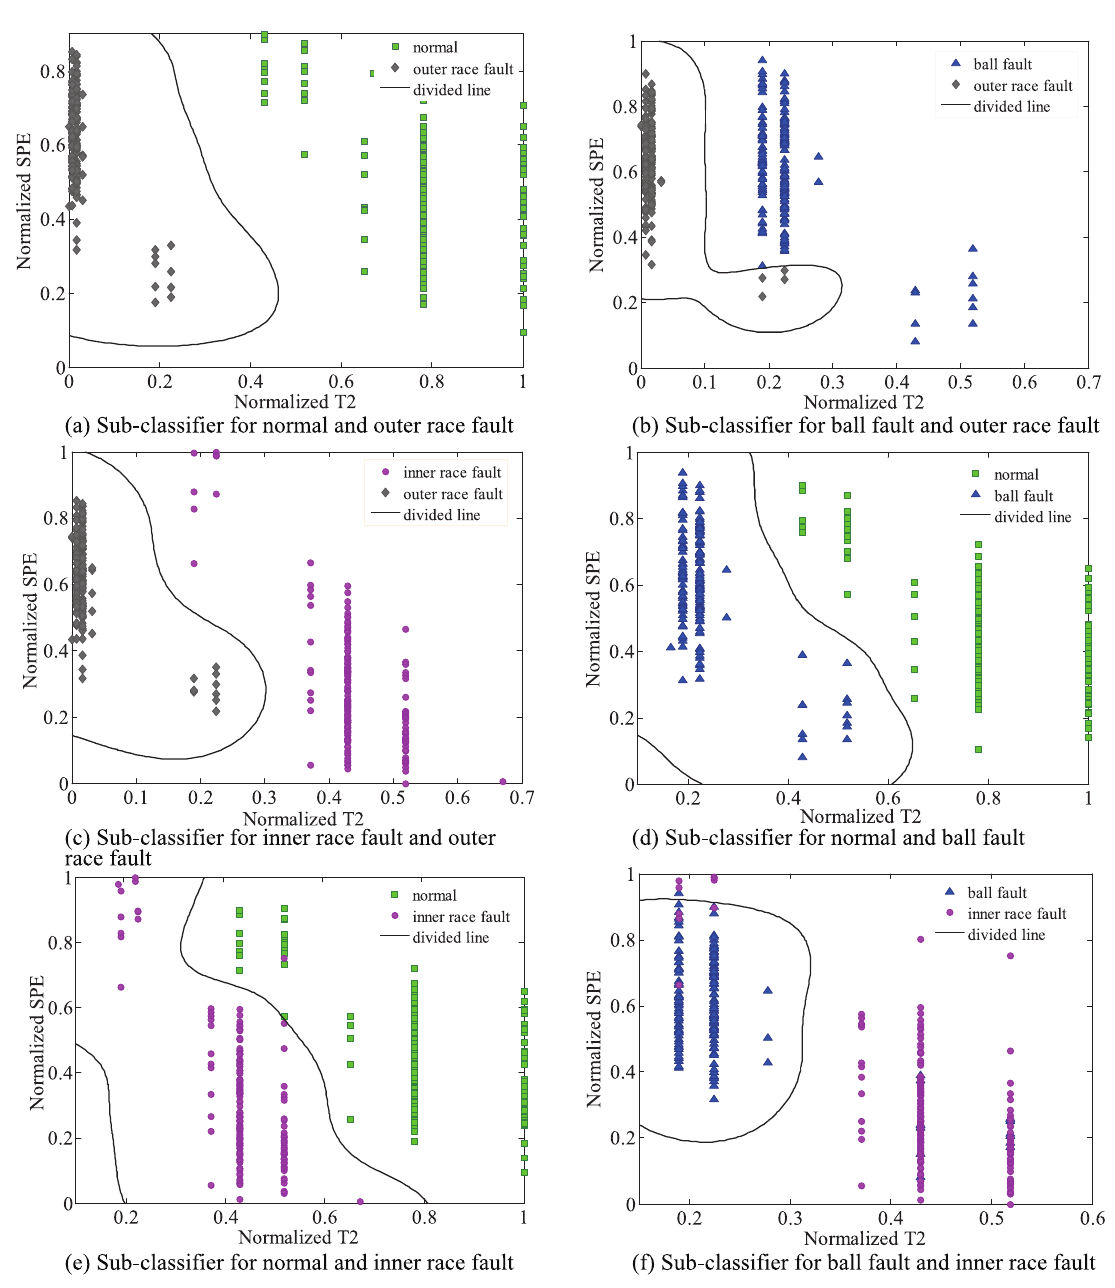
Fig. 6. Classification results of each sub-classifier in multi-class LSSVM in case